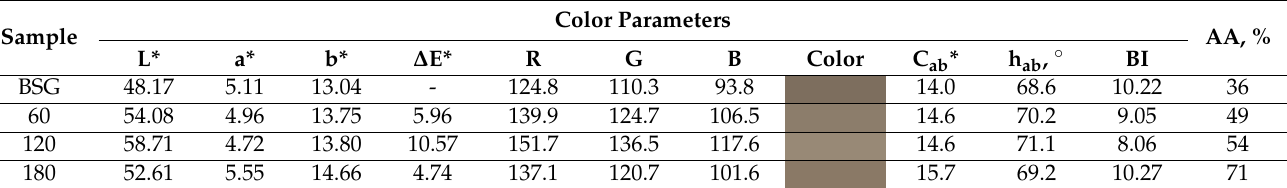
Table 3. Color parameters of the neat and extruded BSG.